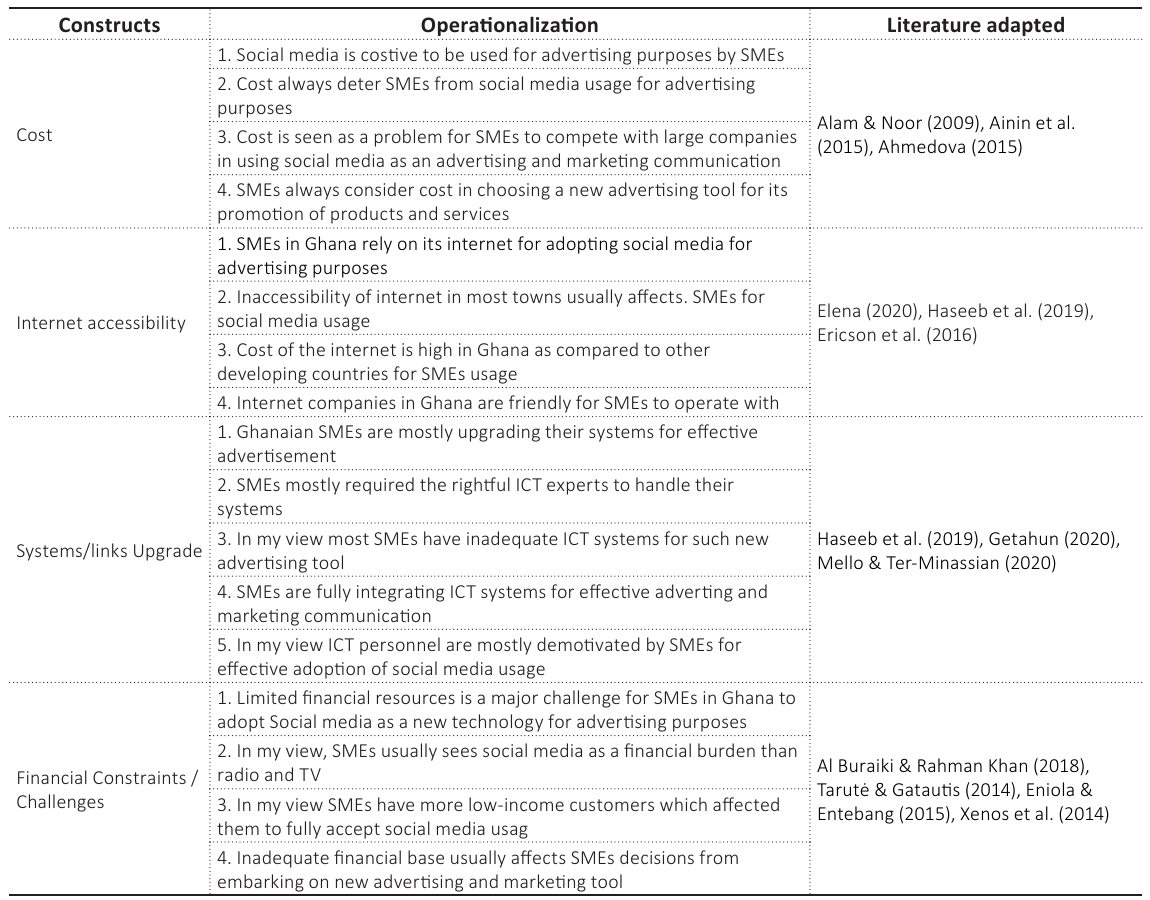
Table 2 (cont.). Measurement of